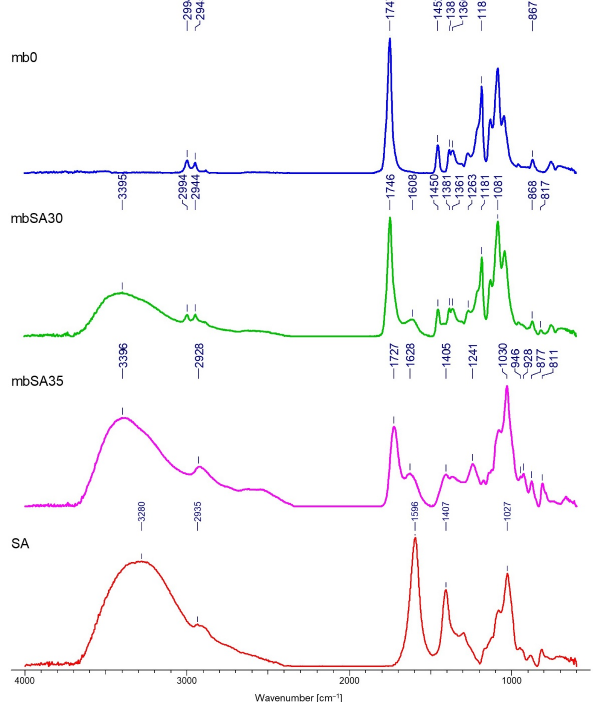
Figure 11. FTIR spectra of the melt ‐ blown PLA nonwoven fabrics with deposition of the sodium alginate layer (SA): mb0—reference sample (melt ‐ blown PLA nonwoven); SA—powder of sodium alginate.